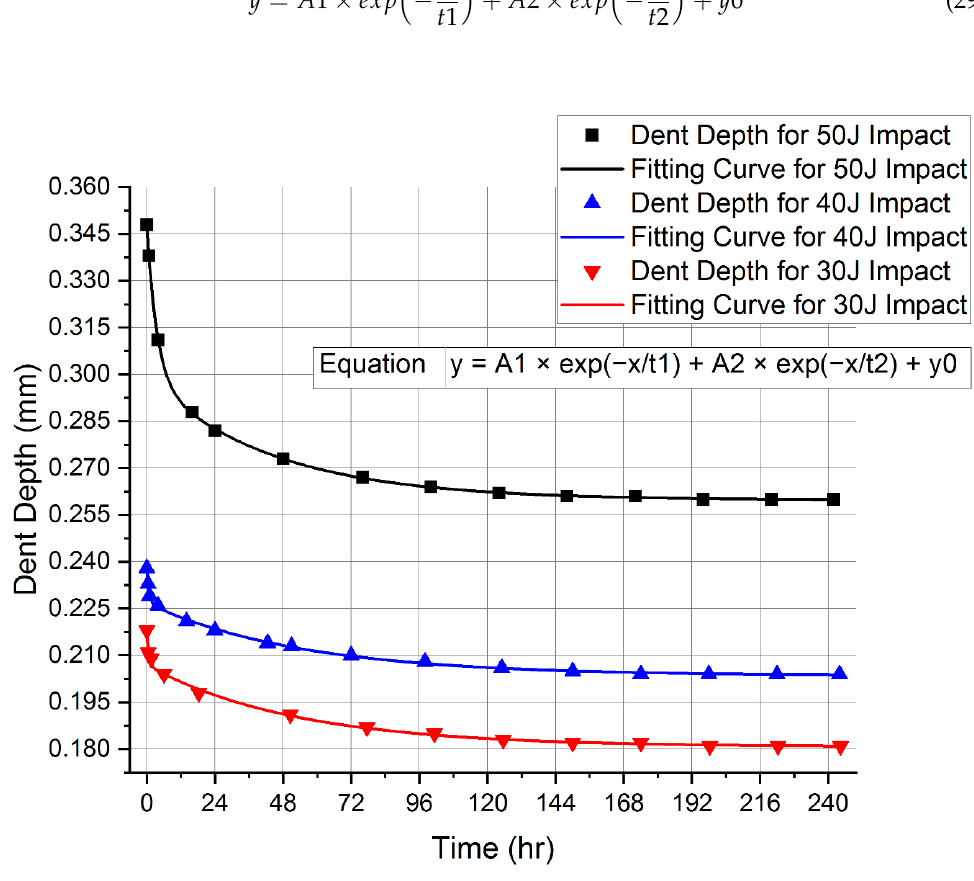
Figure 7. Fitting curves for 30 J, 40 J, and 50 J impact cases: dent depth vs. time graph. The values for variables used in Equation (29) for each impact energy case are given in Table 6. Table 6. Variable values of fitting curve equation for 30 J, 40 J, and 50 J impact cases.